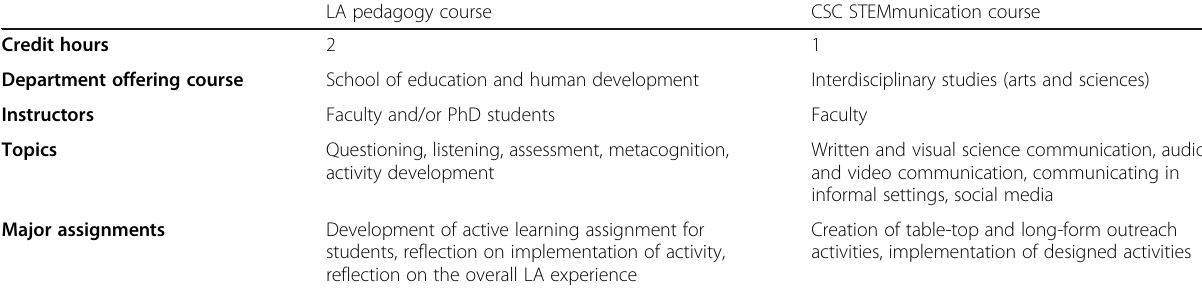
Table 1 Learning assistant pedagogy and STEM clubs communication course